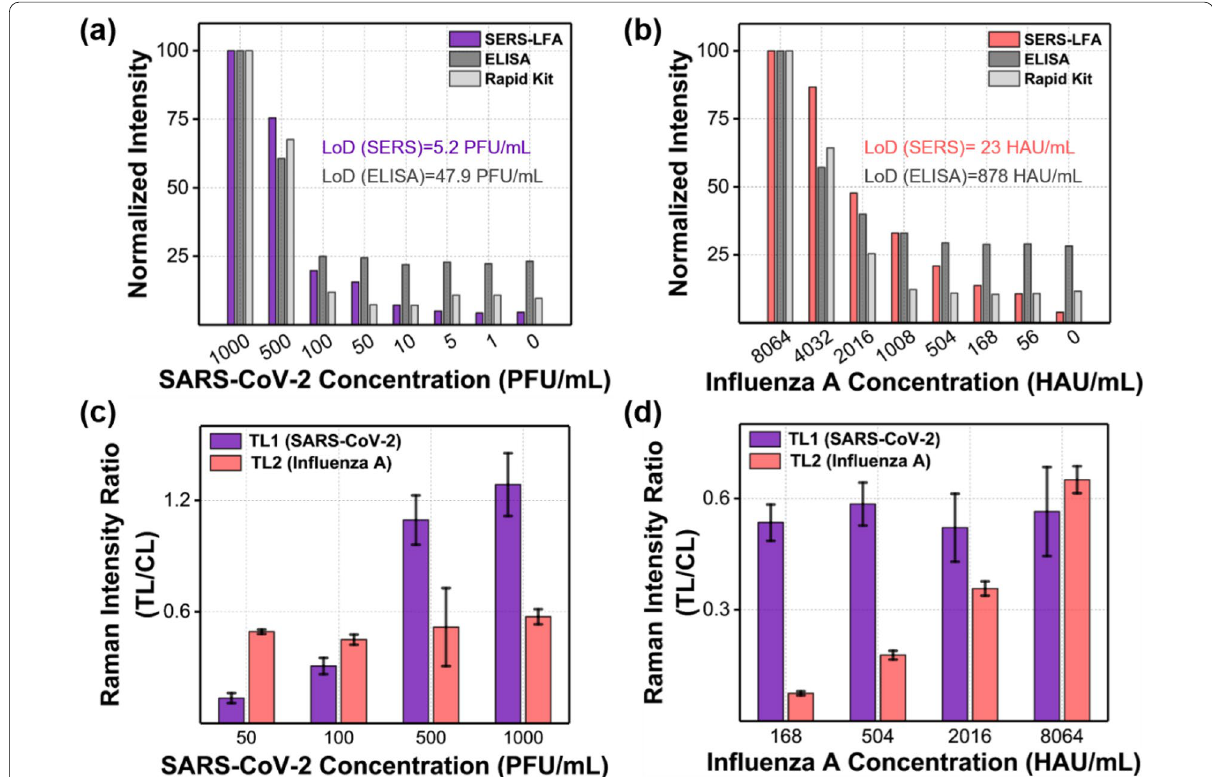
Fig. 5 Cross-reactivity test results of the dual-mode SERS-LFA strip against SARS-CoV-2 and influenza A virus. Normalized intensity variations of SERS-LFA (Raman peak intensity at 1615 cm − 1 ), ELISA (absorbance intensity), and colorimetric LFA (phase contrast intensity) for a SARS-CoV-2 (0–1000 PFU/mL) and b influenza A virus (0–8064 HAU/mL). c SERS intensity ratio variations of test lines 1 and 2 when the SARS-CoV-2 concentration was changed in the range of 50–1000 PFU/mL, but the concentration of influenza A virus was fixed at 8064 HAU/mL. d SERS intensity ratio variations of test lines 1 and 2 when the influenza A virus concentration was changed in the 168–8064 HAU/mL range, but the concentration of SARS-CoV-2 was fixed at 200